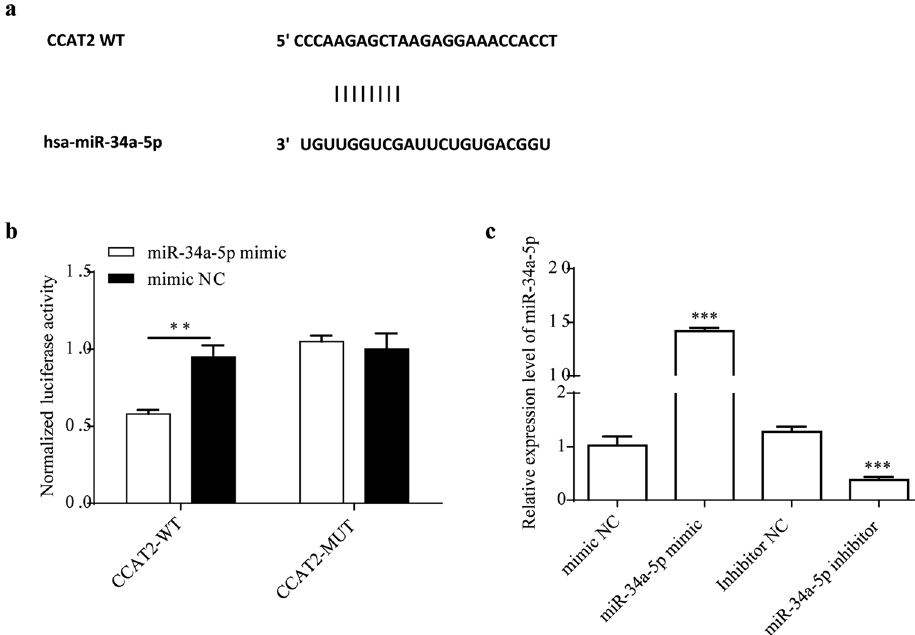
Figure 3. miR-34a-5p interact with 5 ′ -UTRs of CCAT2. Dual luciferase assay of HSCs co-transfected with CCAT2 wild type or mutants and miR-34a-5p mimics or negative